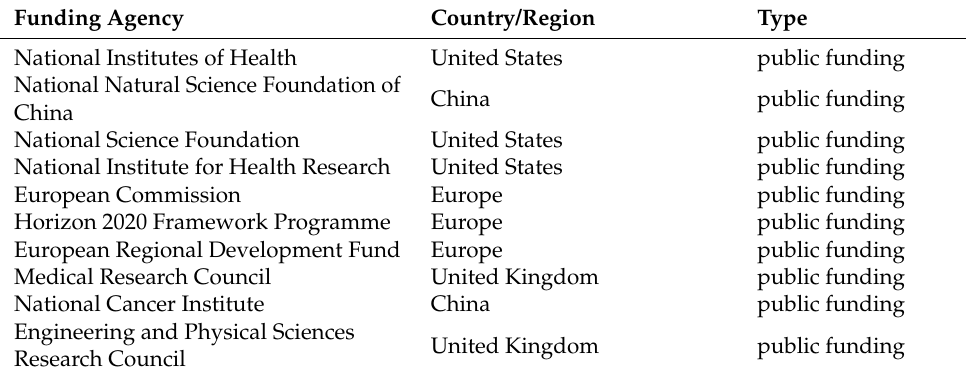
Table 2. Top 10 funding institutions by number of